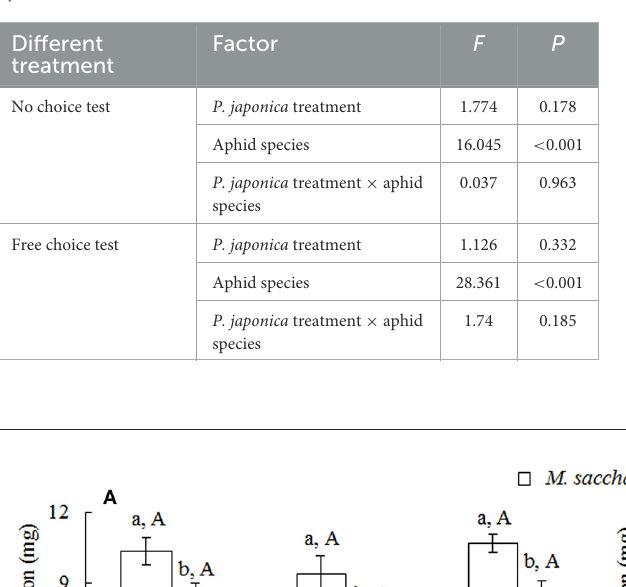
TABLE 2 ANOVA of the effects of P. japonica treatment (fed on different diets) and aphid species on the aphid biomass consumed by Propylaea japonica .